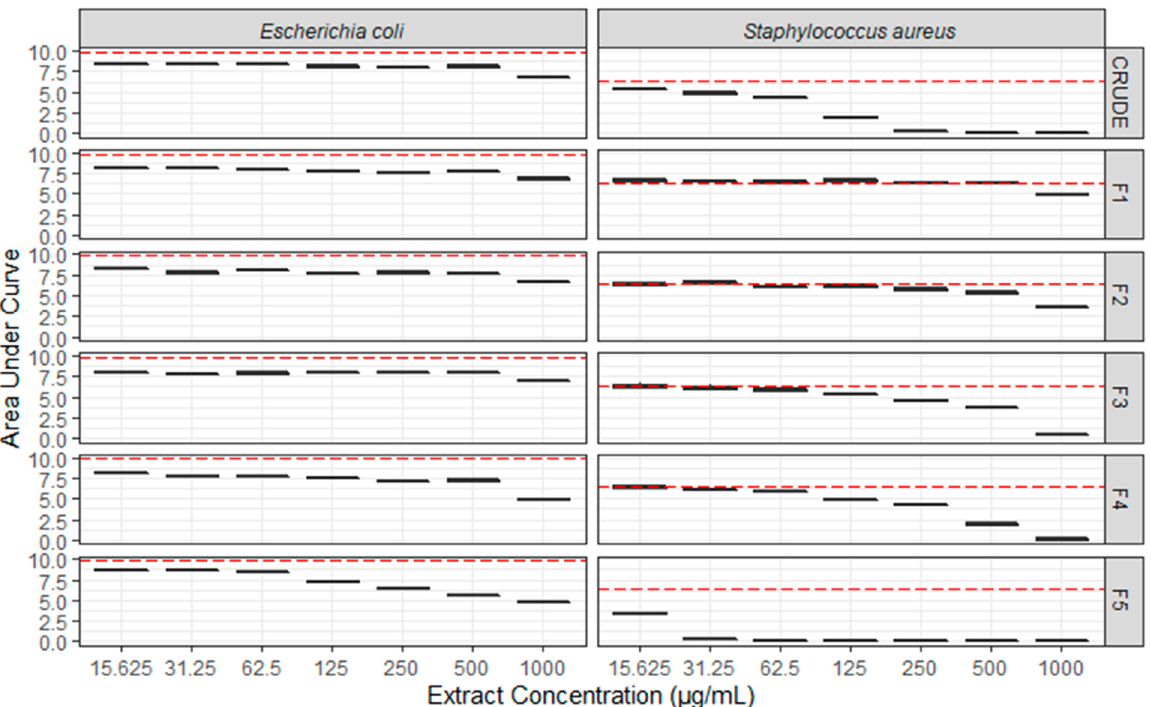
Figure 3. Antibacterial activity of fungal crude extracts and fractions against E. coli ATCC 25922 and S. aureus ATCC 29213. Activity is shown as box-whisker plots of Area Under Curve (AUC) values of changes in optical density at 600 nm. Prior to calculation of AUC, all optical density values were adjusted to account for the absorbance of the fraction alone by subtracting the values from time zero. Dotted line shows AUC values for bacteria without fungal extracts. Raw data are available at doi:10.17608/k6.auckland.11868675 (accessed on 19 February 2021).